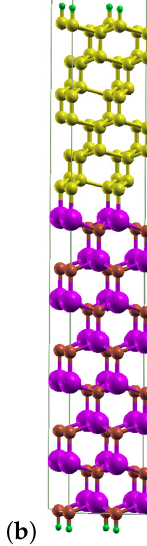
Figure 10. A relaxed diamond–GaN heterostructure with the ( a ) N-C abrupt interface type and ( b ) Ga-C abrupt interface